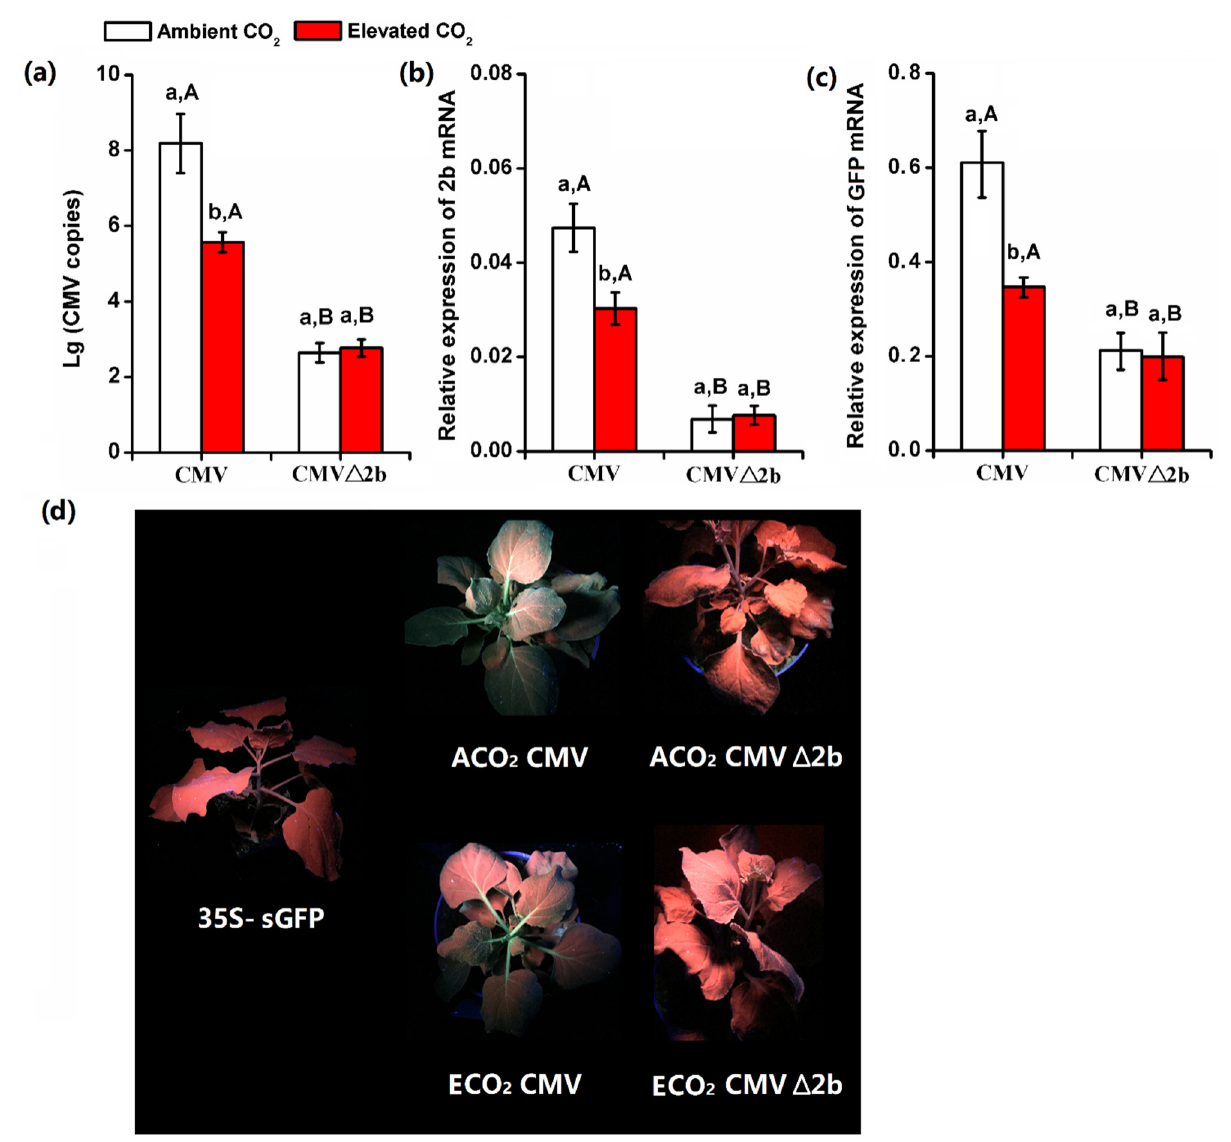
Figure 3. ( a ) CMV viral accumulation and ( b ) the relative expression of 2b mRNA in N. tabacum ( c ) the relative expression of GFP in GFP-transgenic N. benthamiana 16c plants post agroinoculated with CMV and CMV ∆ 2b for 14 days under ambient CO 2 and elevated CO 2 . ( d ) The ability of 2b protein to recover silenced GFP expression in systemic leaves of GFP-transgenic N. benthamiana 16c plants. Data represent means ± SE (Tukey’s multiple range test, p < 0.05). Different lowercase letters indicate significant differences between ambient CO 2 (ACO 2 ) and elevated CO 2 (ECO 2 ) within the same virus treatment. Different uppercase letters indicate significant differences between virus treatments within the same CO 2 treatment ( p < 0.05).